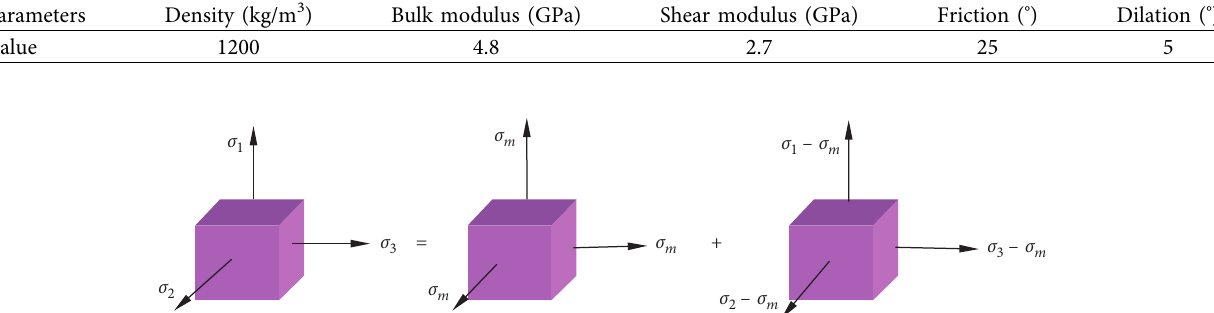
Table 4: The caving material parameters in gob.